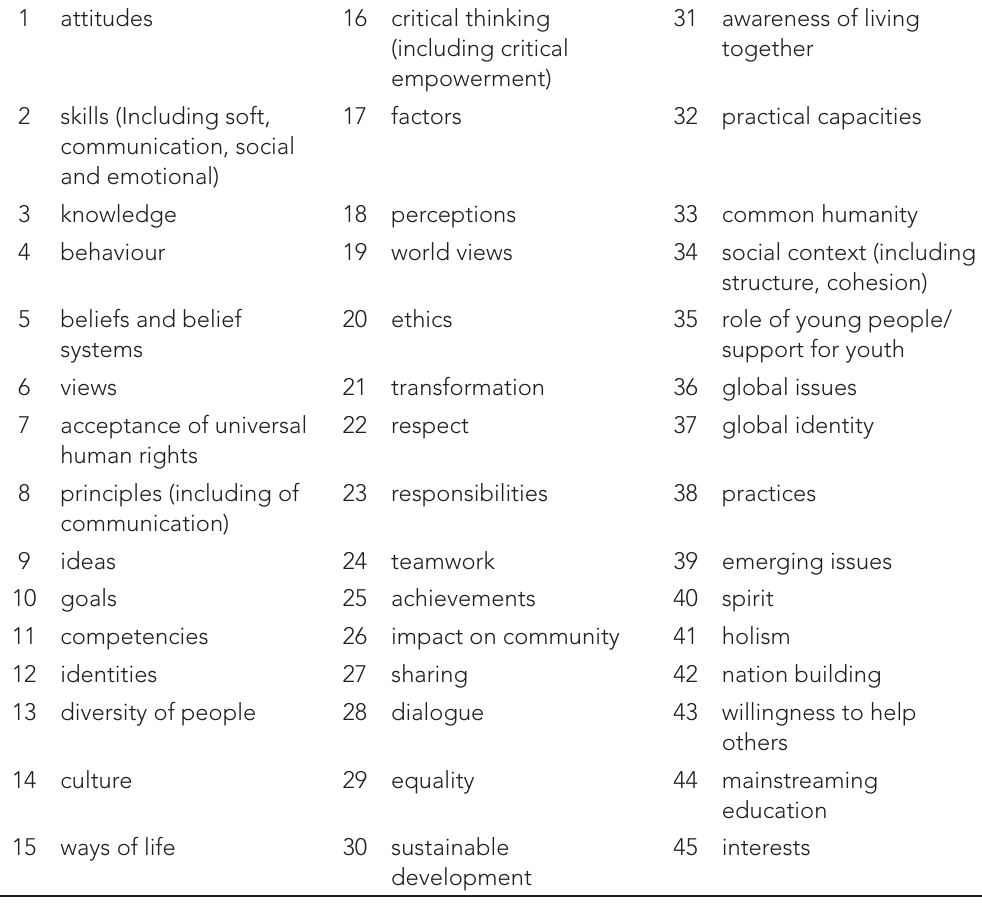
Table 1: List of items in equivalence with values in order of